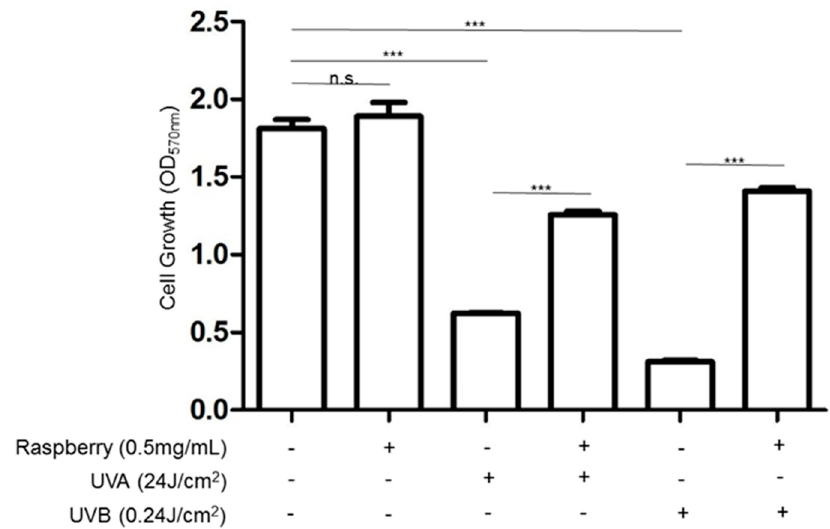
Figure 3. Restore the cell viability with antioxidative raspberry extract under UVA and UVB exposure. MTT assays were applied to evaluate the e ff ects of red raspberry extract on keratinocyte (HaCaT cell) growth with or without ( + or -) the treatment of UVA and UVB. The cells were exposed to 0.5 mg / mL red raspberry extract and the data were the mean ± SD of three independent experiments. (*** p < 0.001; n.s., not